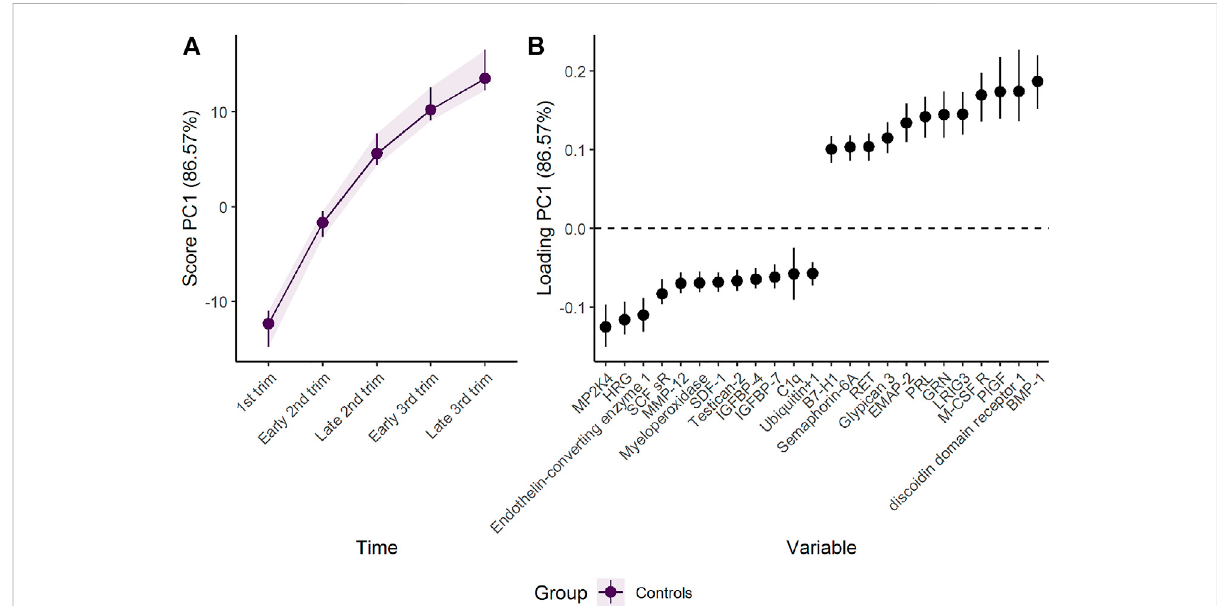
FIGURE 2 Timedevelopmentoftheplasmaproteomethroughoutpregnancyas (A) scoresand (B) loadings.Theplasmalevelofproteinswithhighloading isincreasingwhenthescoresincreaseand viceversa .Onlythe12 proteinswithhighestandlowestloadings,separatedbytheverticaldottedline,are shown due to the large number of assessed